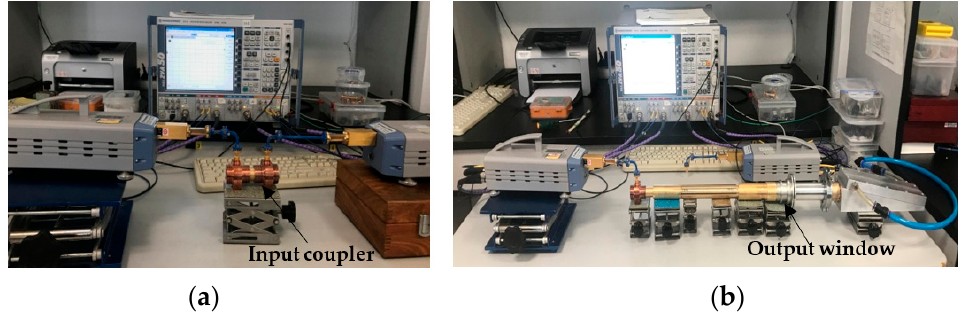
Figure 11. Cold test of the critical components of the W-band gyro-TWT by VNA ( a ) Input coupler; ( b ) Output window.